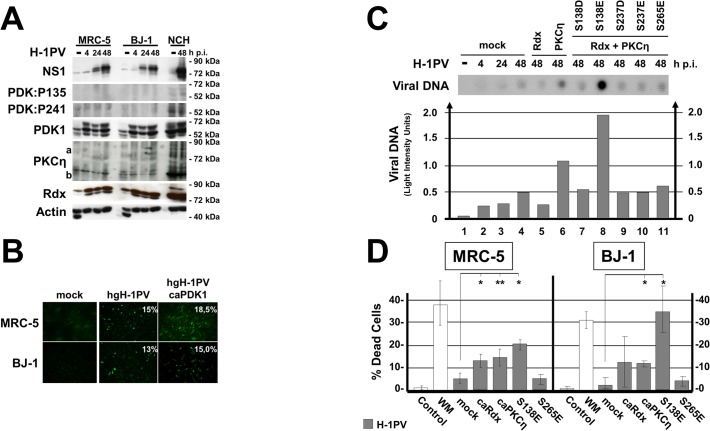
Impact of activated PDK1 on cell permissiveness for PV infection.(A) Normal human fibroblasts (MRC-5 and BJ-1) and human glioma cells (NCH149) were infected (or not) with H-1PV (30 pfu/cell) and harvested at the indicated times p.i. Activated PDK1 was detected by western blotting as PDK1phosphoS135 (PDK:P135) and as autophosphorylated PDK1phosphoS241 (PDK:P241). Total PDK1, viral NS1, PKCη, and Rdx were quantified in parallel. Actin was used as loading control. (B) MRC-5 and BJ-1 cultures grown on spot slides were transfected (or not) with rAAV:PDK1S138E (caPDK1) and infected 24 h thereafter with H-1PV. The proportion of cells having initiated virus replication was determined by measuring NS1 expression by immunofluorescence staining 24 h p.i. (C, D) Normal human cells were transfected (or not) with rAAV (104 rAAV genomes/cell) expressing the indicated PDK1, PKCη, or Rdx variant under the control of the PV P4 promoter and infected with (30 pfu/cell) H-1PV 24 h after transduction. Accumulation of viral DNA in the transfected MRC-5 cells was determined by dot blot hybridization (C, upper panel) and expressed in light intensity units (C, lower panel). (D) The proportion of dead cells was measured by PI staining 48 h p.i. Data are presented as means with standard deviation bars of three independent experiments and significance of the changes compared to mock treated cells were determined by student’s test at p-values p<0,01 (*) and p<0,02 (**), respectively.